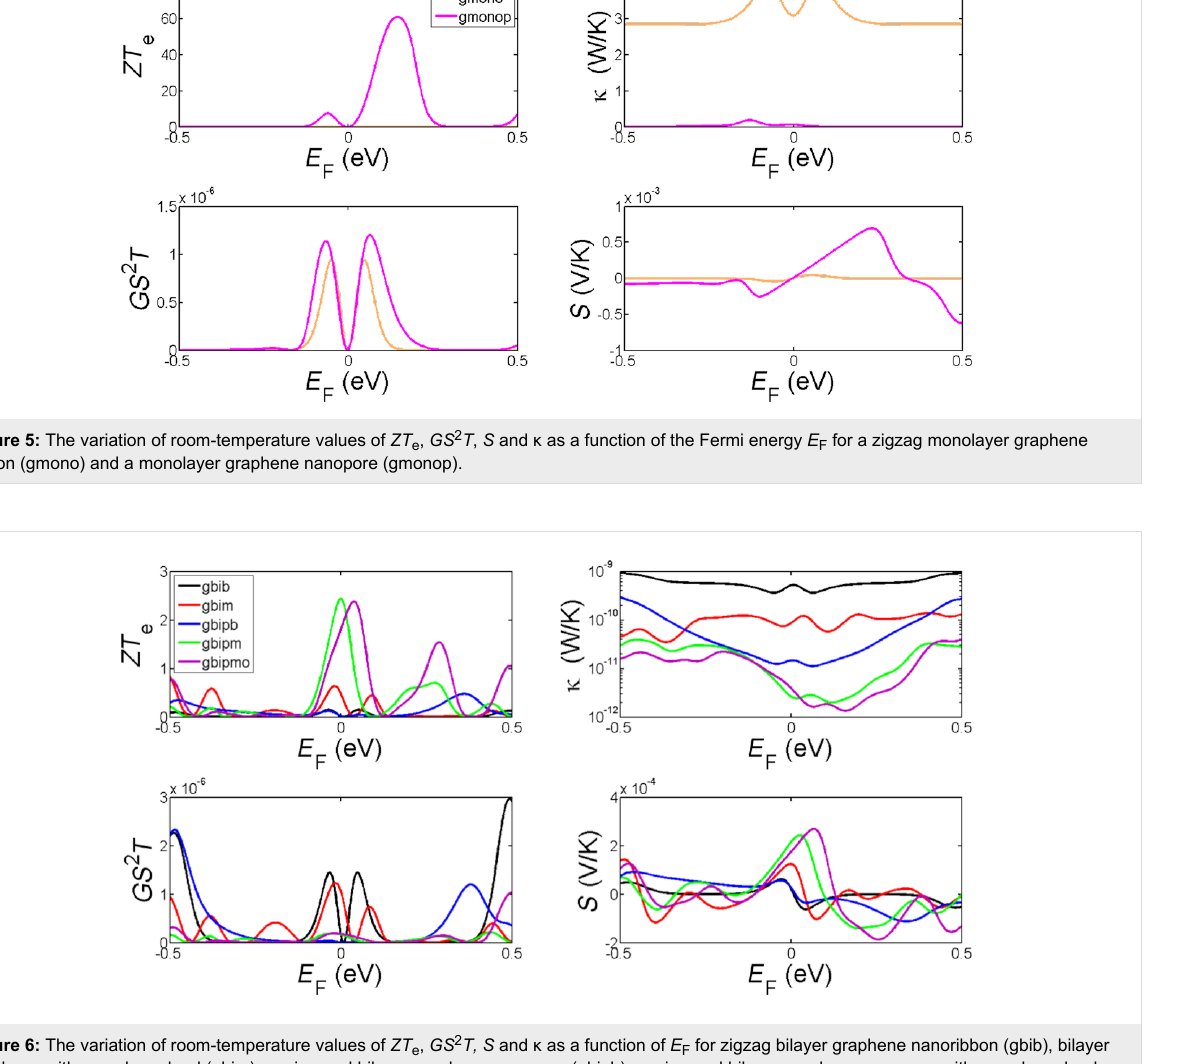
mal conductance be reduced due to the fact that the inter-layer coupling is weaker than the intra-layer C–C coupling, but ZT e is increased by shifting the Fermi energy to the right (as in p doping) as it is clear by comparing the red and black curves in Figure 6. This improves ZT e from 0.01 to 0.5 in E F = 0. The second strategy involves introducing pores in bilayer graphene. This shift and improvement of ZT e is even higher when a pore is created in both layers, such that the top graphene layer is connected to the bottom graphene layer by the internal surface of the pore, as shown by the green and purple curves in Figure 6. This type of nanostructuring would also reduce the phonon contribution to the thermal conductance. By this tech- nique the Fermi energy is shifted more to the left and ZT